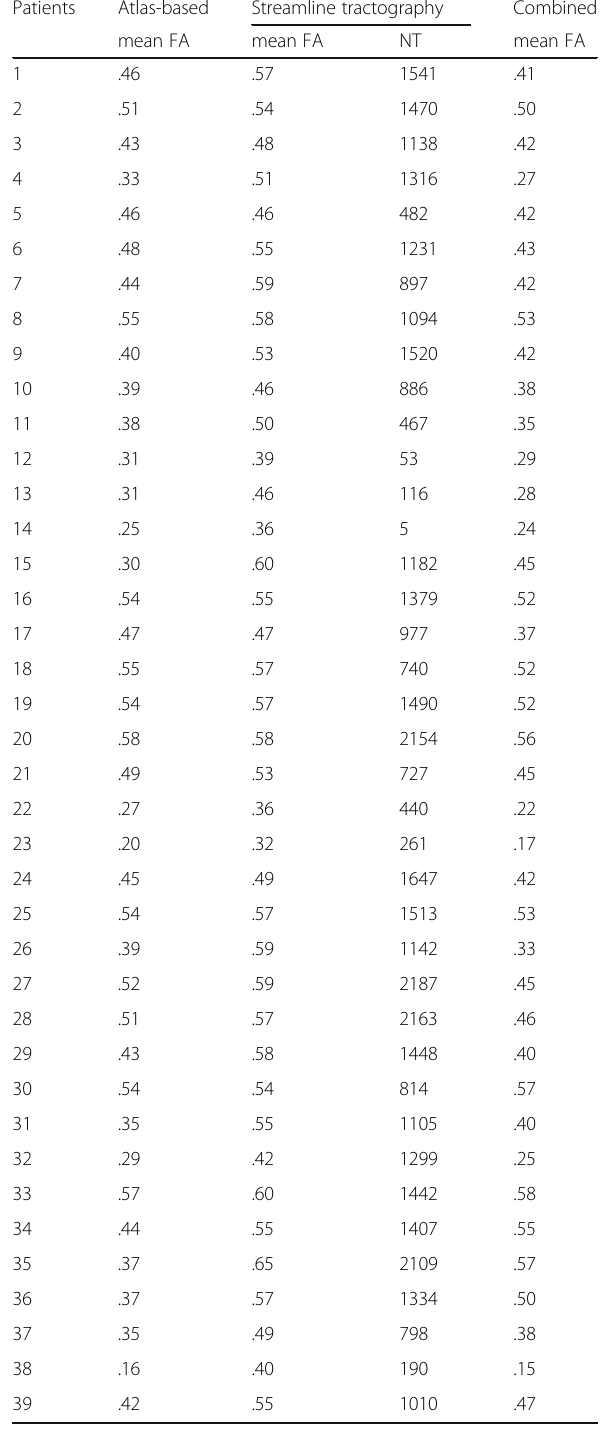
Table 3 Mean fractional anisotropy and number of tracts within the corticospinal tract in each patient derived from all approaches (atlas-based, streamline tractography, and